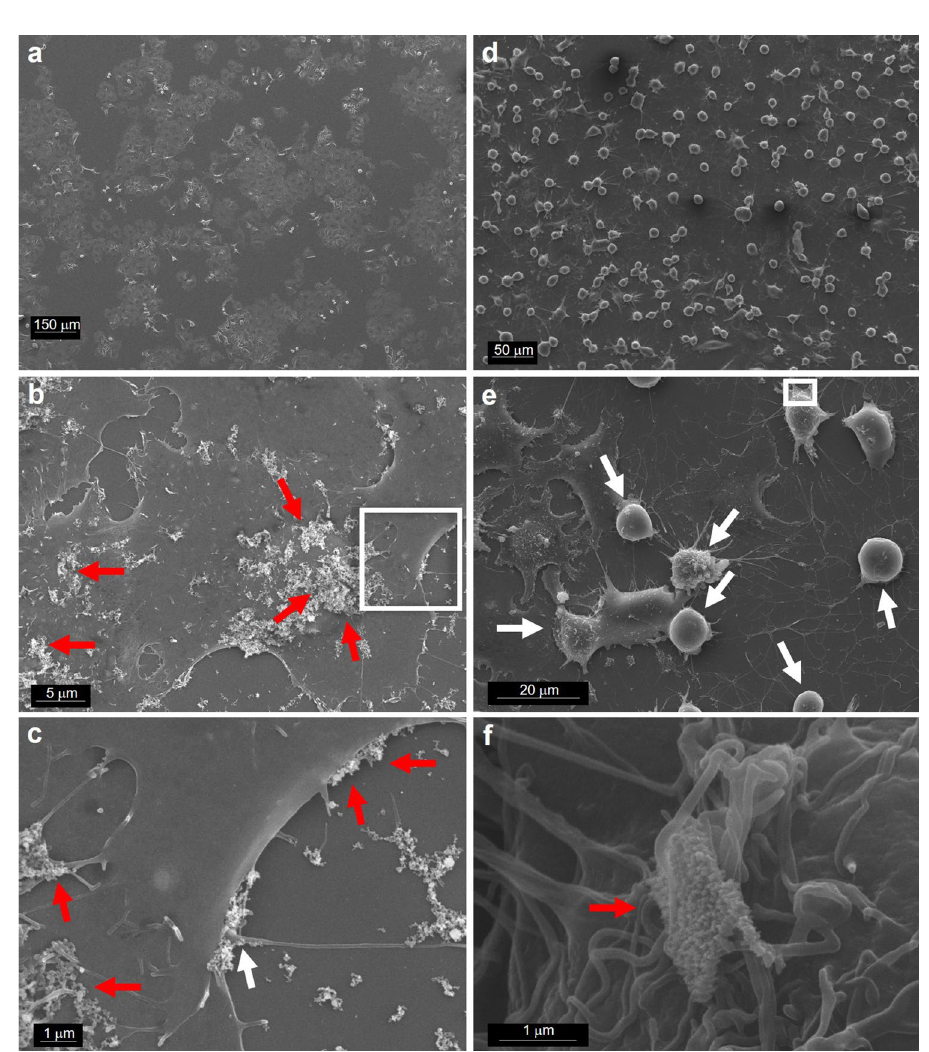
Figure 6. SEM images of A549 exposed for 3 h to CuO NPs. ( a ) unexposed cells; ( b ) cells exposed to cCuO at 50 μg/ml—aggregates of nanoparticle are visible on the cell surface (red arrows); ( c ) detail of ( b )—white frame—showing cCuO interacting with the plasma membrane; ( d , e ) different magnifications of cells exposed to sCuO at 50 μg/ml—numerous mitotic/apoptotic cells (white arrows) are appreciable; ( f ) detail of ( e ) showing sCuO NPs agglomerate on cell surface (red